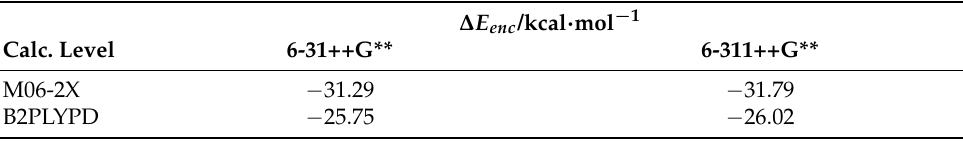
Table A1. The encapsulation energy ∆ E enc for H 2 O · HF@C 70 , calculated by selected approaches a and inclusion of the CP3 BSSE and steric